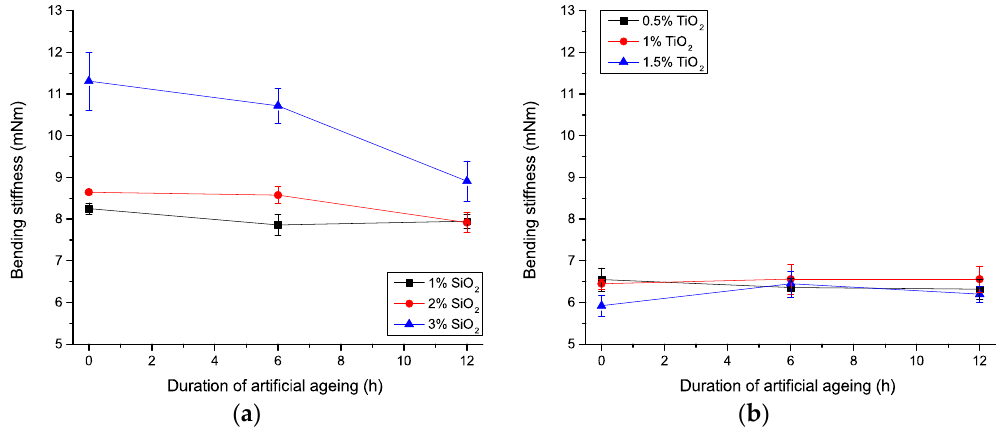
Figure 10. Bending stiffness of the unaged and aged FC with addition of ( a ) SiO 2 ; ( b ) TiO 2 nanoparticles.